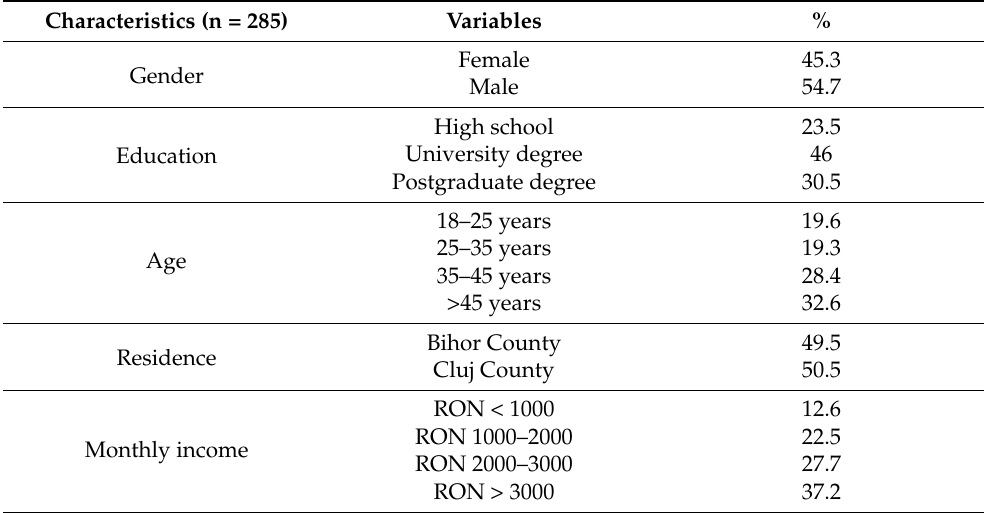
Table 1. Socio-Demographic Profile of the